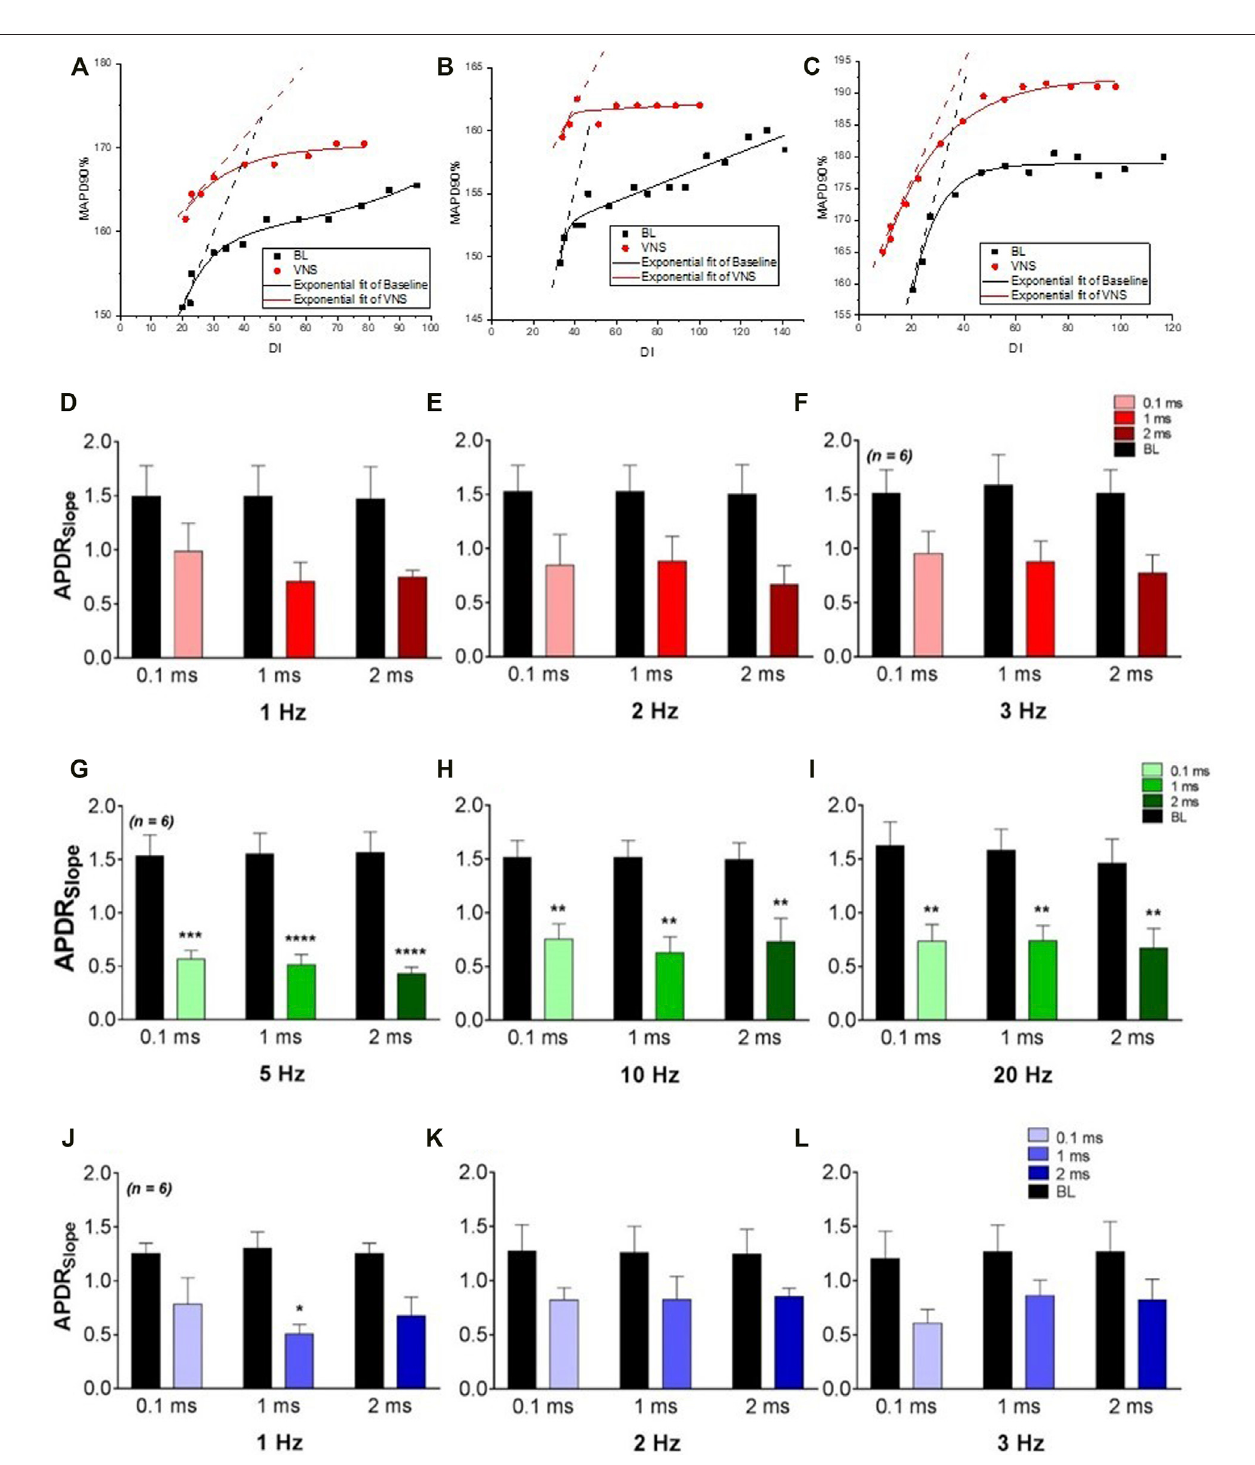
FIGURE1| The effects ofvaryingVNS on the maximum slope ofrestitution. (A – C) , plotsofAPD restitution curves from atypical experiment at baseline and during high voltage (A) , low voltage (B) and low voltage-low frequency (C) VNS. The maximum slope of restitution at baseline (BL) and during high voltage (D – F) , low voltage (G – I) and lowvoltage-low frequency (J – L) VNS at pulse widths of0.1 m 1and 2 ms. Datarepresentmean ±SEM.* p < 0.05, ** p < 0.01, *** p < 0.001, **** p < 0.0001 vs. corresponding BL, n = 6.